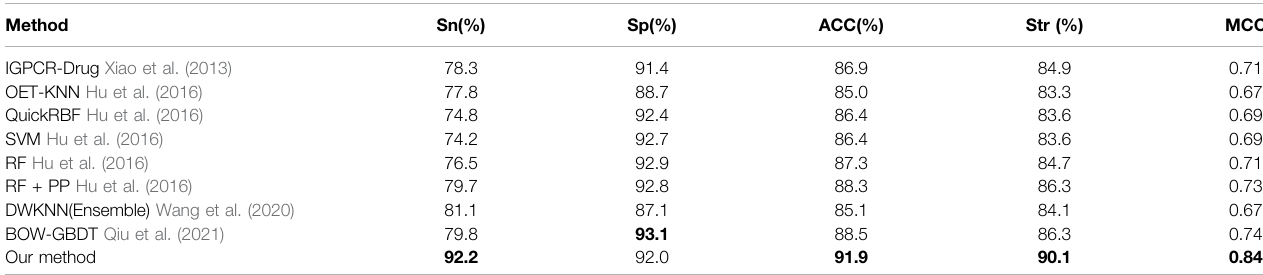
TABLE 3 | Performance comparison on GPCR dataset over leave-one-out cross-validation.